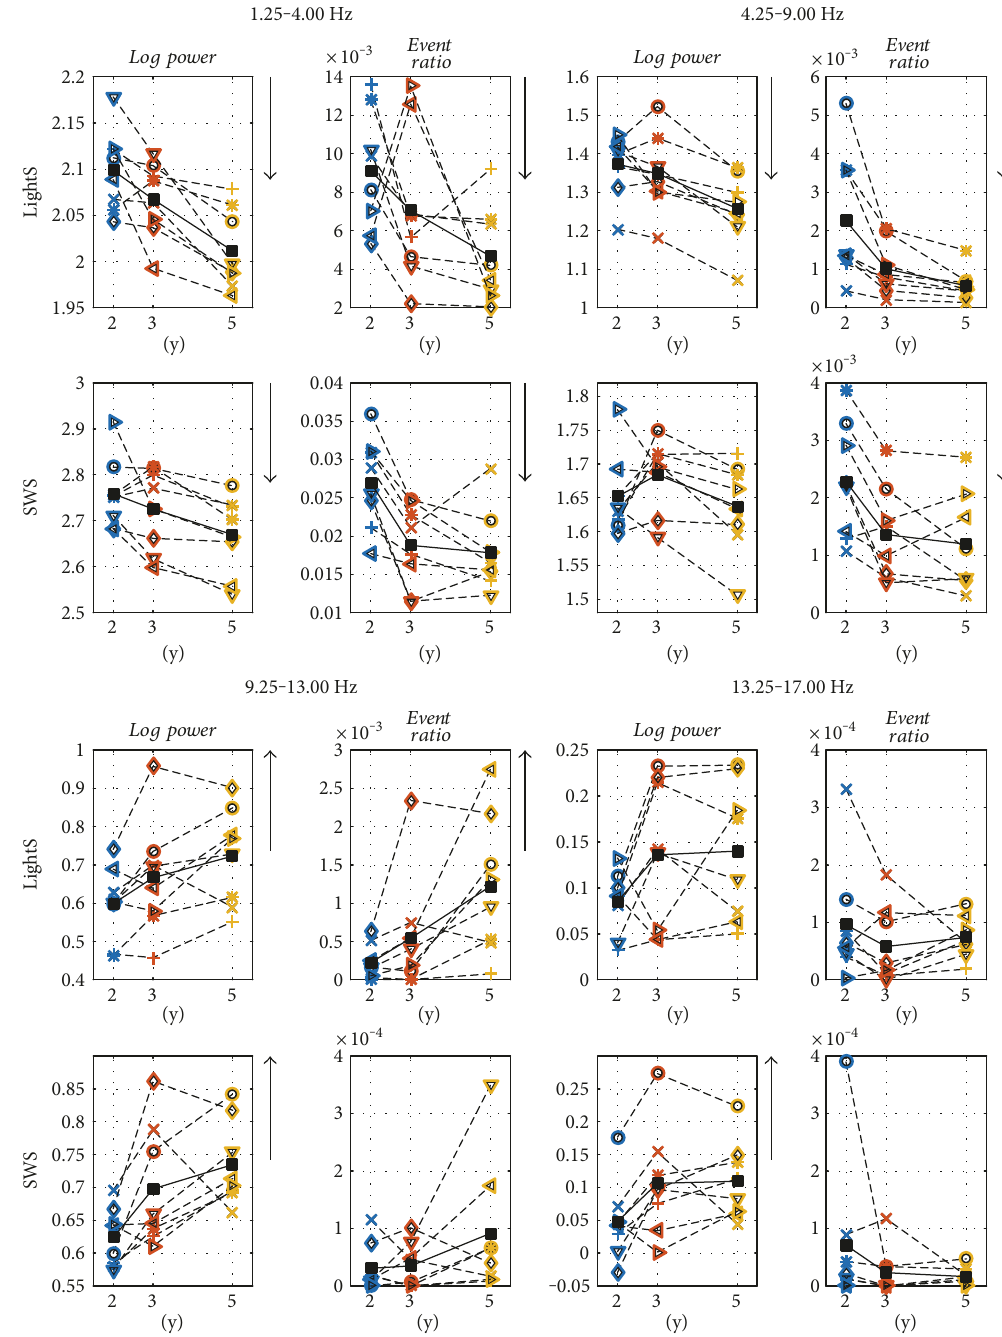
Figure 4: Mean power (log10) and event ratios of three frequency bands (delta 1.25 – 4.0Hz; theta 4.25 – 8Hz; and sigma 9.25 – 13.0 and 13.25 – 17.0Hz) at three longitudinal time points (2, 3, and 5 years of age) to illustrate the developmental change in NREM sleep. Light sleep (LightS: NREM sleep stages 1 and 2) and slow-wave sleep (SWS: NREM sleep stages 3 and 4) were analyzed. Dashed lines and the di ff erent symbols illustrate individual children and the black squares and lines average data ( n = 8 ). Arrows indicate the direction of signi fi cant ( p < 0 05 ) age- dependent changes (repeated measures ANOVA factor “ age ”